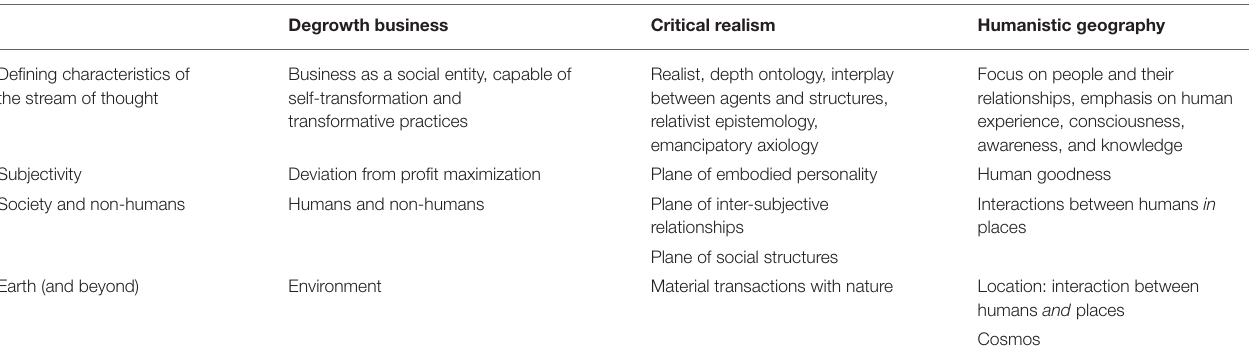
TABLE 1 | Degrowth, critical realism and humanistic geography as lenses for